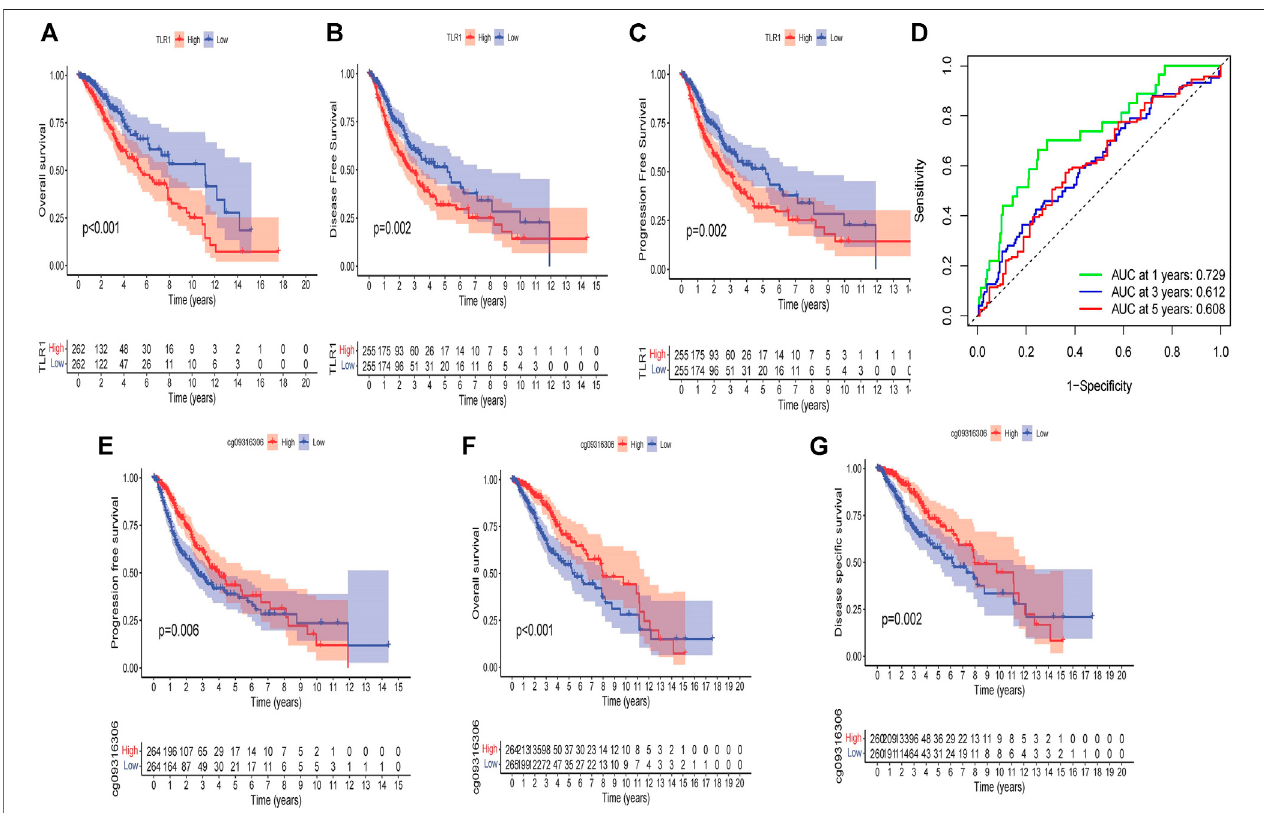
FIGURE4| Kaplan-Meiercurves. (A) oversurvivalinallpatients,groupedbylowandhighTLR1expression. (B) disease-freesurvivalinallpatients,groupedbylow andhighTLR1expression. (C) progressionfreesurvivalinallpatients,groupedbylowandhighTLR1expression. (D) AUCvaluesforpredictingLGGsurvivalratesat1,3, and5 years. (E) progressionfreesurvivalinallpatients,groupedbylowandhighmethylationlevelofcg09316306site. (F) oversurvivalinallpatients,groupedbylowand high methylation level of cg09316306 site. (G) disease-speci fi c survival in all patients, grouped by low and high methylation level of cg09316306